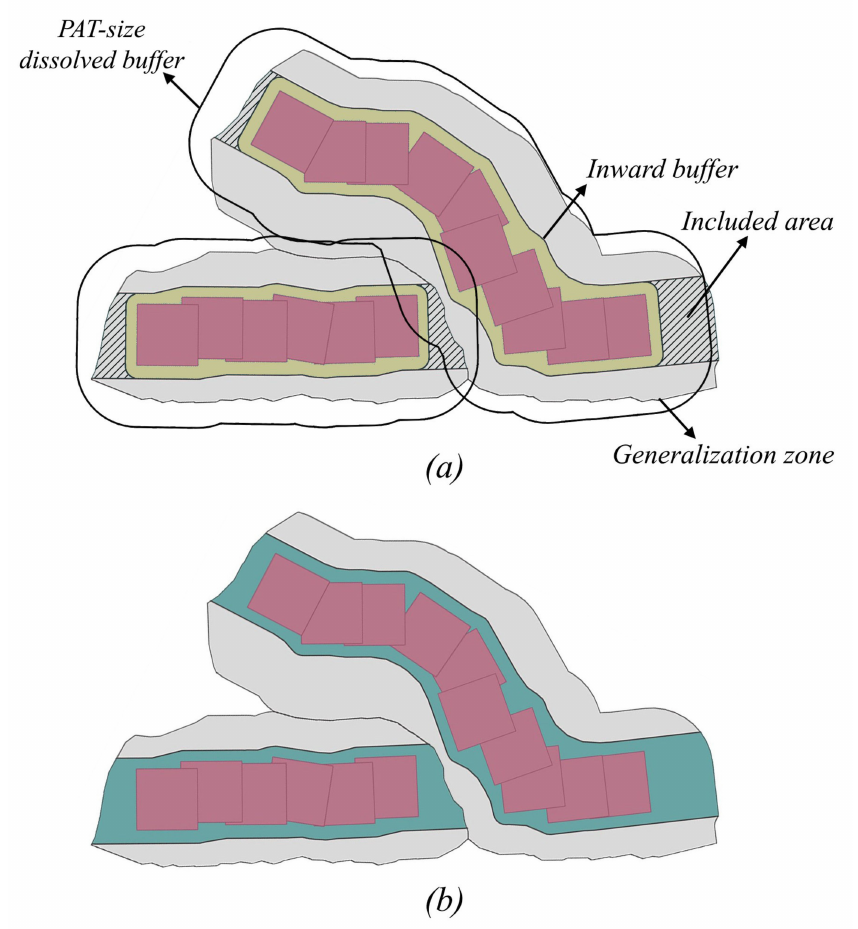
Figure 4. Narrowed zones of linear (collinear and curvilinear) patterns. ( a ) The inward 20 m buffer of the PAT-size-dissolved buffer (yellow) and the included areas (hatched); ( b ) the narrowed zones